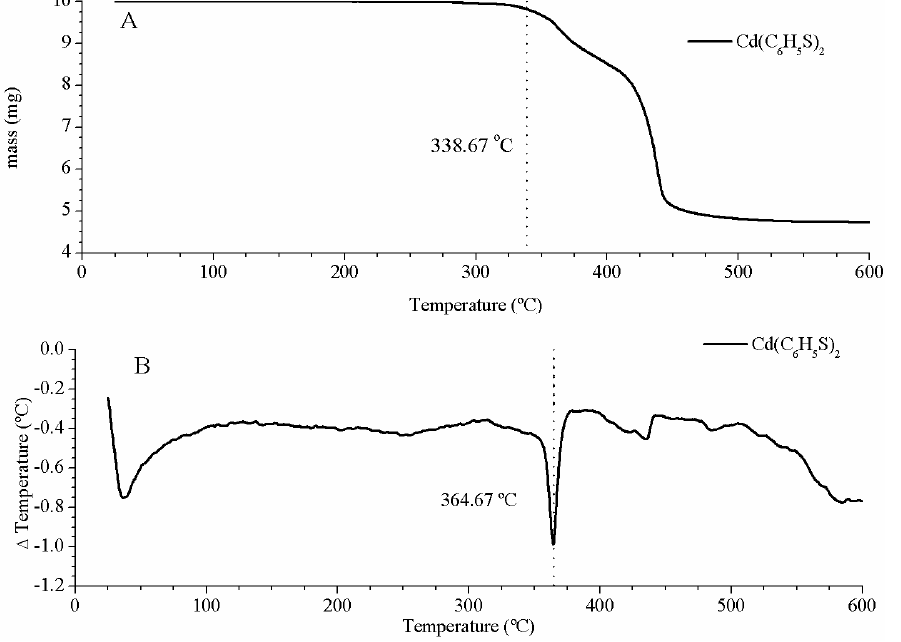
Figure 5. Cd(C 6 H 5 S) 2 —thermal gravimetric analysis (TGA) ( A ). Cd(C 6 H 5 S) 2 —differential scanning calorimetry (DSC) ( B ).